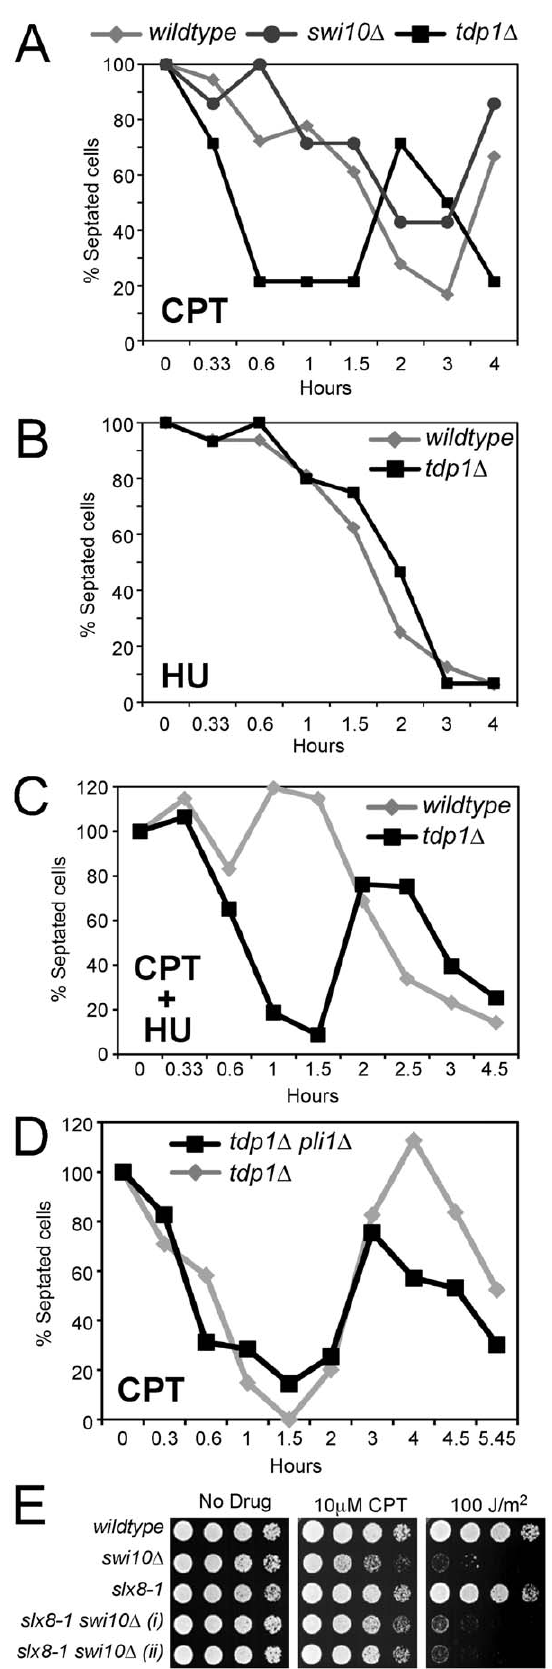
Figure 6. STUbL facilitates Top1cc repair in the Rad16-Swi10 pathway. (A) Log phase cultures of the indicated strains were treated with 40 m M CPT and checkpoint arrest and recovery was monitored through determining the percentage of septated cells at the indicated times. (B) As for (A), except cultures were treated with 15 mM HU. (C) As for (B), except cultures were co-treated with 15 mM HU and 40 m M CPT. (D) The indicated strains were treated with CPT and checkpoint arrest and recovery were monitored as in (A-C). In all of these graphs, the asynchronous septation index was set at 100% for that observed at time zero in each strain studied. (E) The indicated strains were serially diluted and spotted on drug-free or CPT rich media, or were UV-irradiated at the indicated dose, and incubated at 25 u